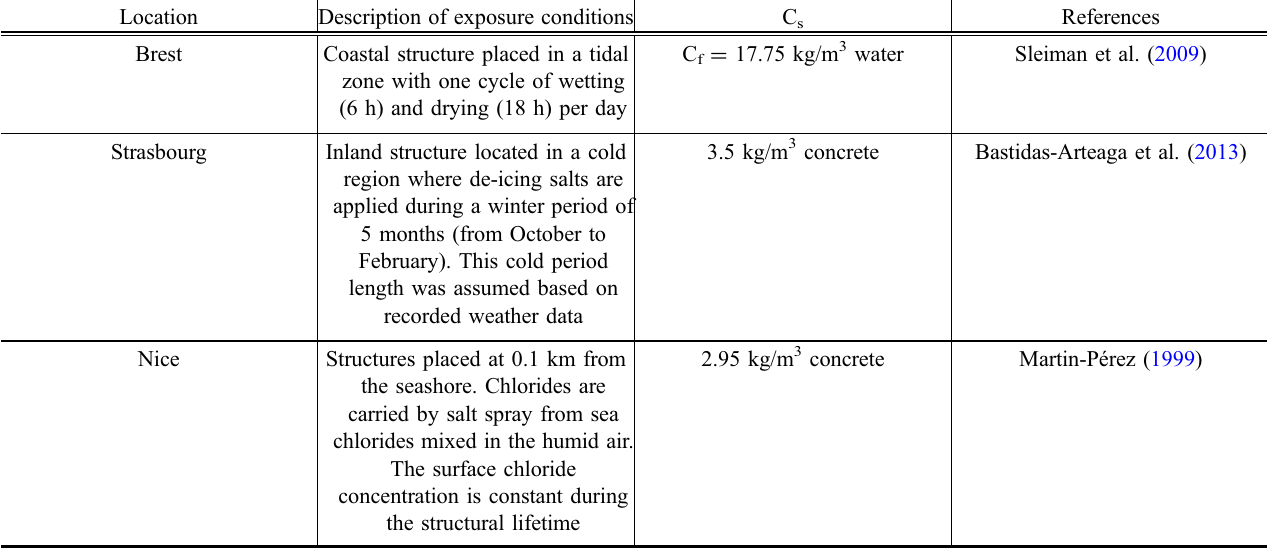
Table 1 Exposure conditions for each location.